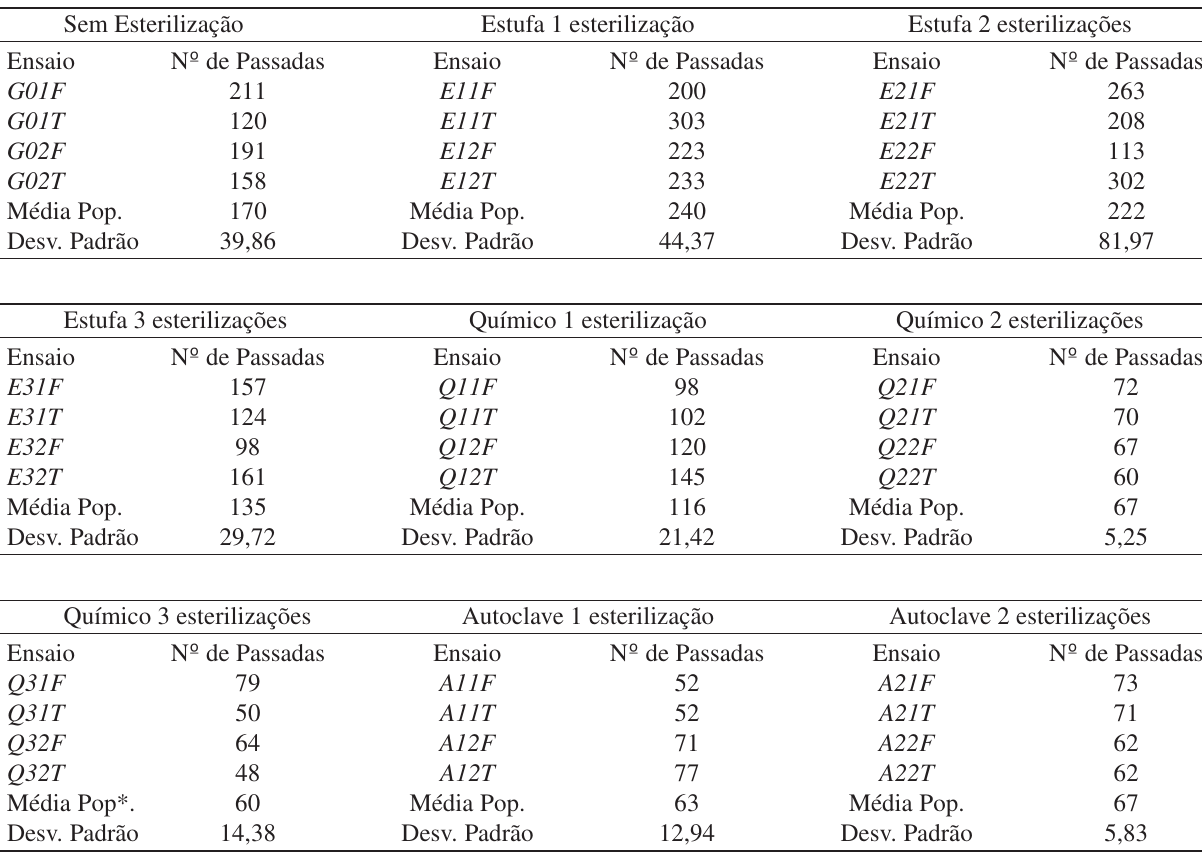
Tabela 3. Resultados obtidos para as pontas ensaiadas.